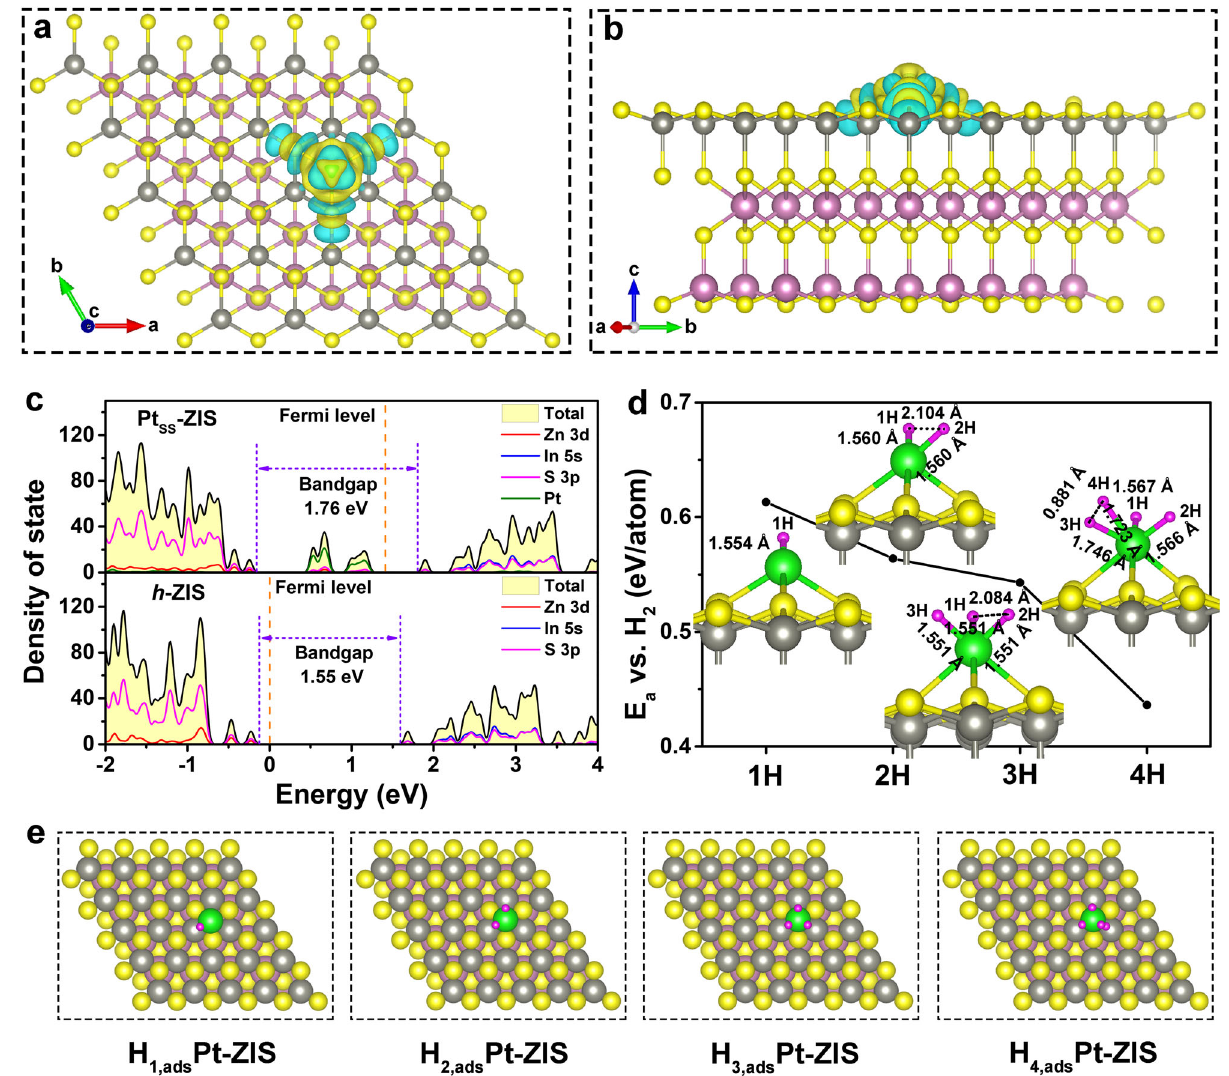
Fig. 5 Density functional theory (DFT) calculations. a Top and b side view of calculated charge difference surfaces of Pt SS -ZIS with yellow and cyan colors represent positive and negative electron density isosurfaces, respectively. The value of isosurface is 0.002e/bohr 3 . c Density of states of the h -ZIS and Pt SS -ZIS. d Calculated adsorption energies of H atoms as a function of the H coverages (from one H atom to four H atoms) on the single Pt atom photocatalysts with h -ZIS as support. The H – H and Pt – H distances are shown in the fi gure. The adsorption energies (E a ) were calculated by: h i = n. The yellow, gray, pink, green, and purple spher e s represent the S, Zn, In, Pt, and H atoms, respectively. e Side view þ n (cid:3) E E a ¼ E Pt E H Pt SS (cid:3) ZIS þ nH 2 SS (cid:3) ZIS 2 of Pt SS -ZIS schematic structure with one H atom, two H atoms, three H atoms, and four H atoms chemisorbed on Pt atom, termed as H 1,ads Pt-ZIS, H 2,ads Pt- ZIS, H 3,ads Pt-ZIS, and H 4,ads Pt-ZIS,